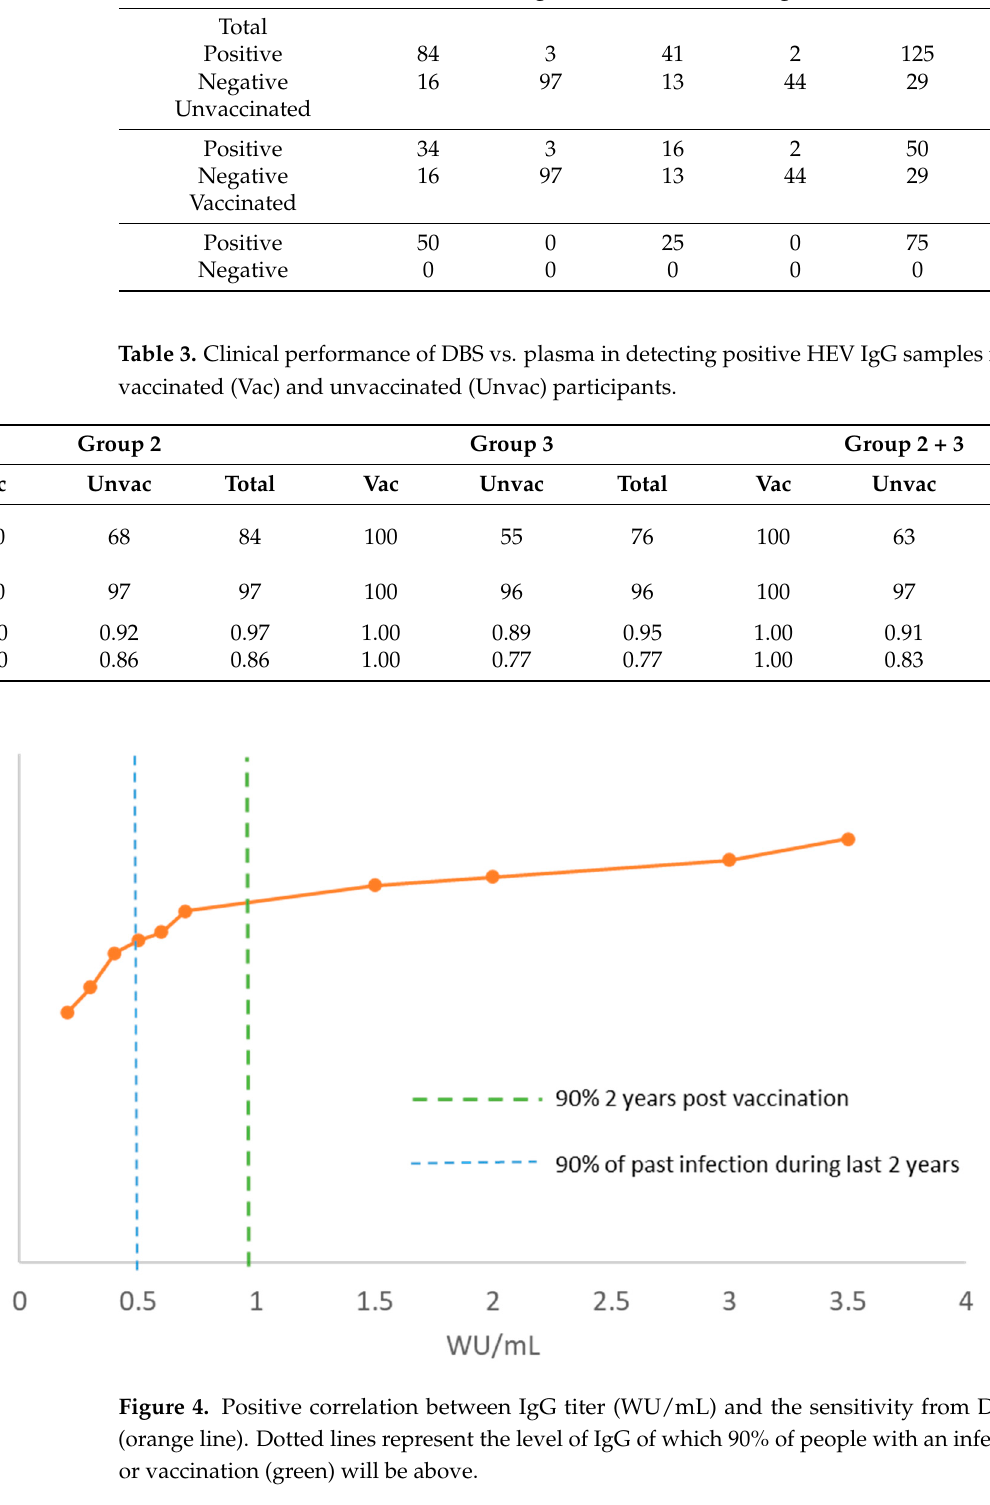
Figure 5. Correlation between IgG concentrations obtained from plasma and DBS, standardized to WU/mL, based on the results from 300 paired DBS and plasma samples. FP = False positive, TP = True positive, TN = True negative, FN = False.